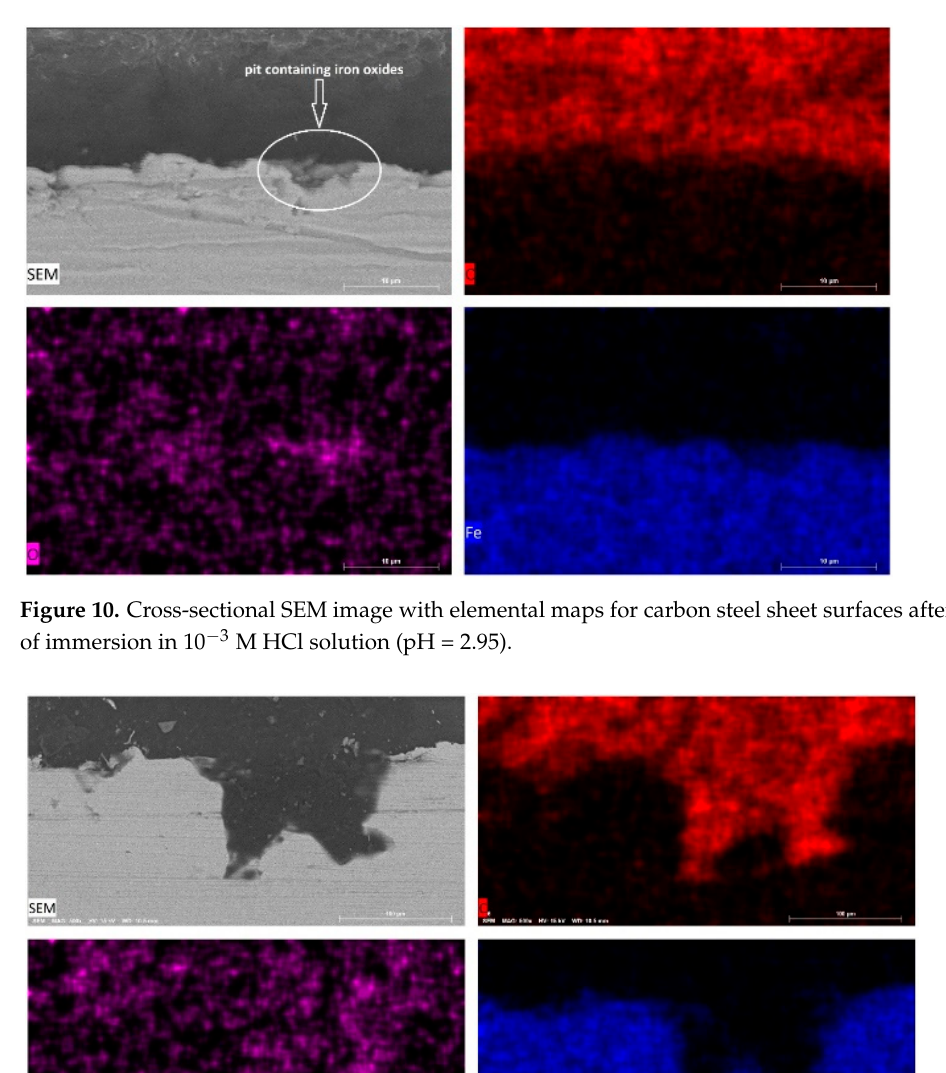
Figure 11. Cross-sectional SEM image with elemental maps for carbon steel sheet surfaces after 12 h of immersion in tomato juice (pH = 4.24).